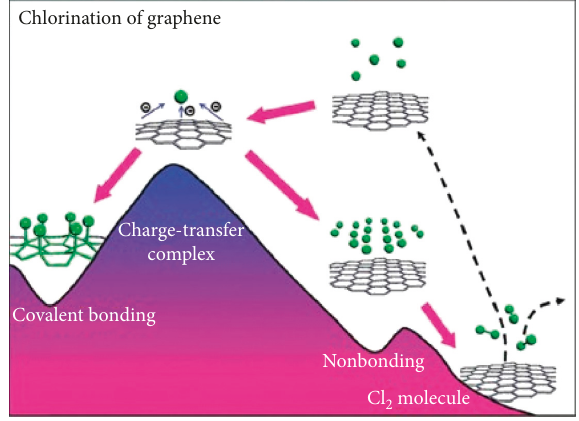
Figure 12: Schematic diagram for the evolution of various ad- sorptions [39].